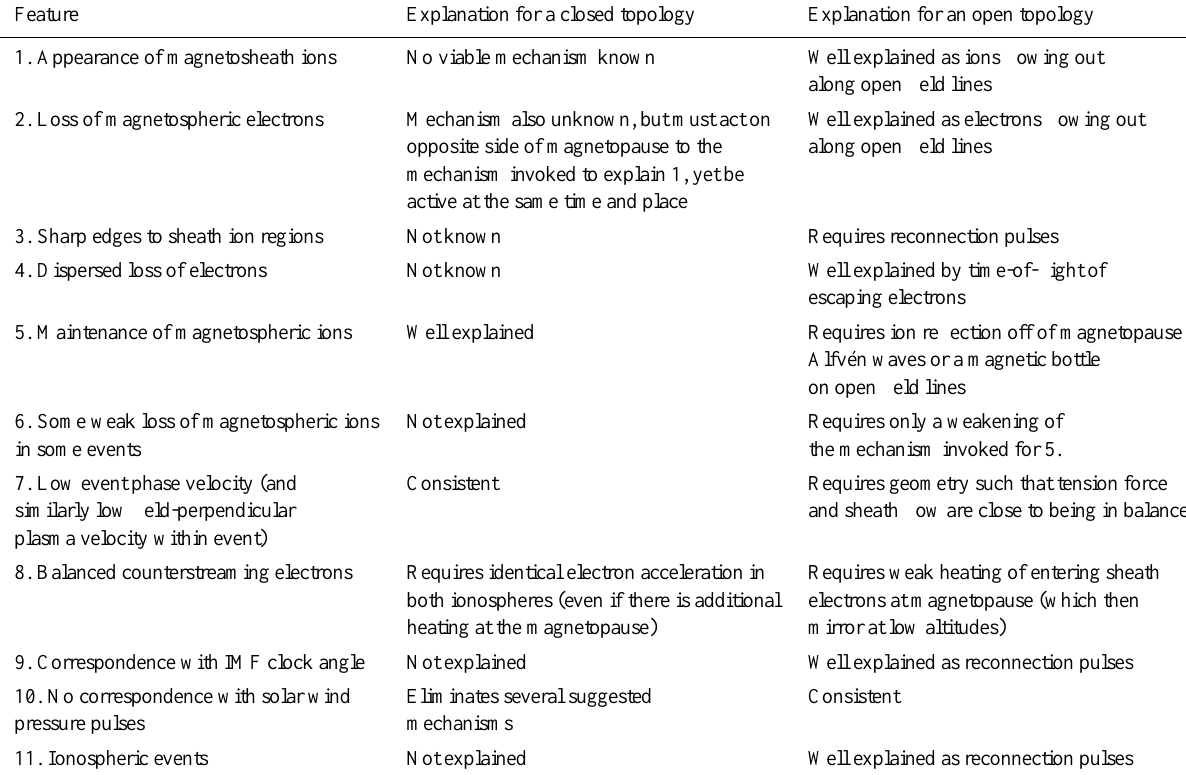
Table 2. Summary of explanations of observed features of the LLBL events